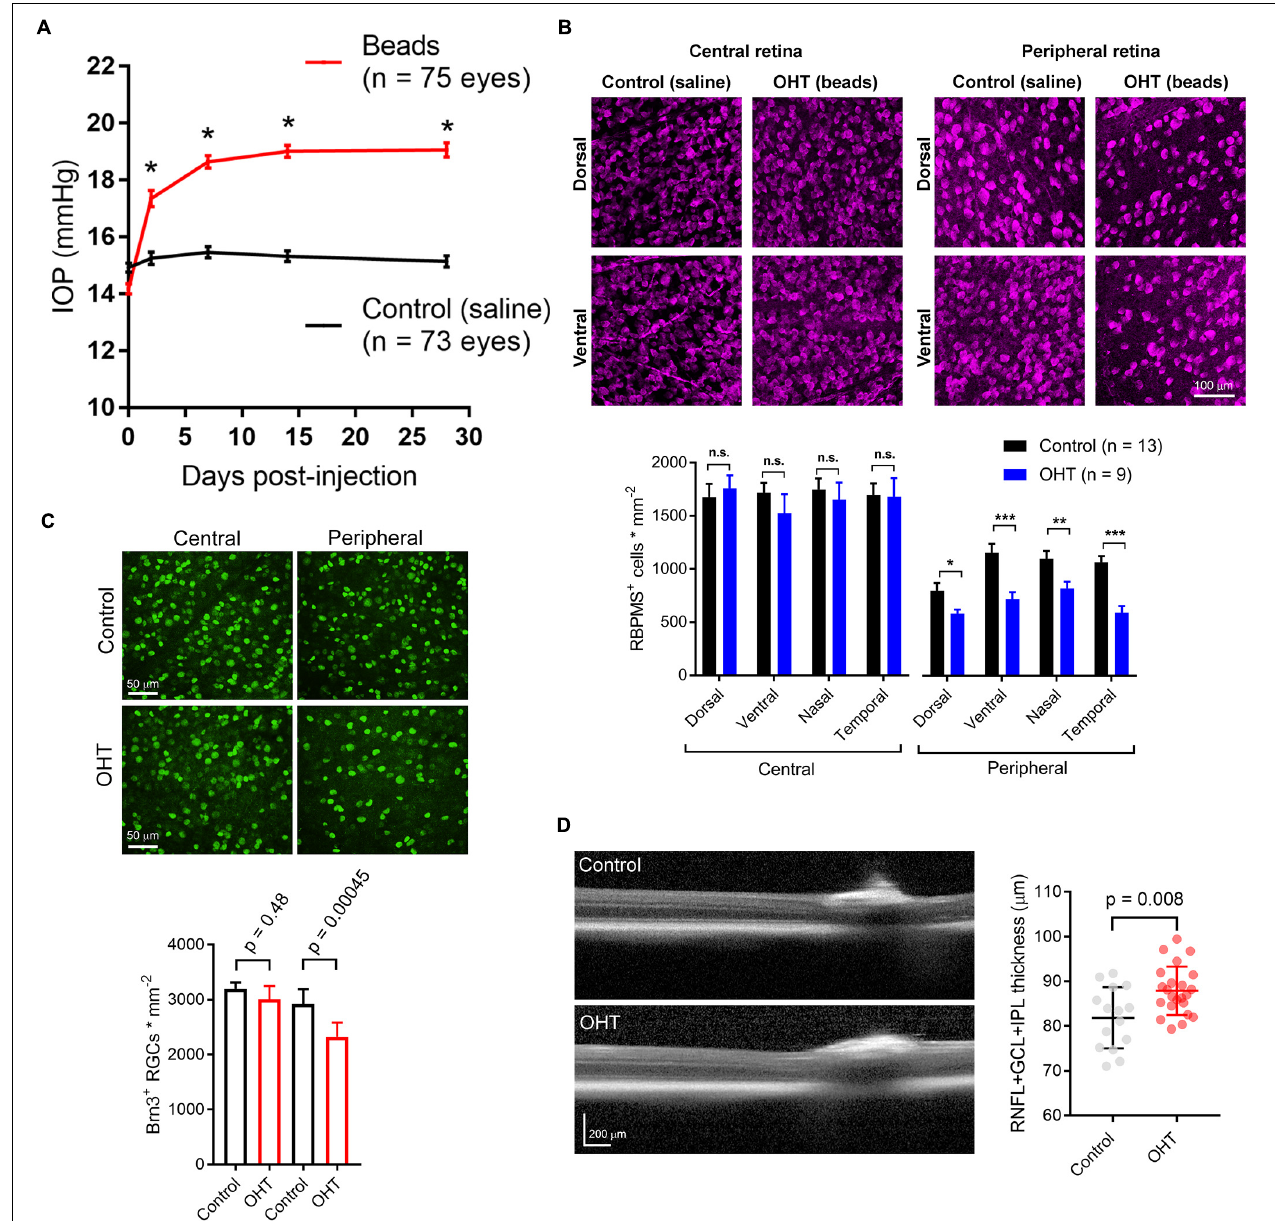
FIGURE 1 | Ocular hypertension leads to retinal ganglion cell loss and inner retinal pathology. (A) Anterior chamber injection of 10-micron microspheres led to an increase in intraocular pressure (IOP) while injection of saline did not. ∗ p < < 0.005. (B) 2-photon image of retinal ganglion cells labeled with an anti-RBPMS antibody. Images from ventral and dorsal quadrants are in central and peripheral retina ( ∼ 500 and ∼ 1700 µ m from optic nerve head) from saline- and bead-injected mice are shown. Lower panel shows quantification of RBPMS antibody-stained RGC density in central and peripheral retina showing lower RGC density in peripheral, but not central, retina in bead-injected mice. ∗ p < 0.05; ∗∗ p < 0.01; ∗∗∗ p < 0.001. (C) Images from central and peripheral retinas of RGCs labeled with and anti-Brn3 antibody. One eye received anterior chamber microbead injections while the contralateral eye received saline. Lower panel is quantification of Brn3 + RGC density showing a lower density in peripheral retina. Significance was assessed with a paired t -test ( n = 7 retinas from bead-injected and n = 7 retinas from contralateral saline-injected eyes). (D) Optical coherence tomography image showing identification of retinal layers. The RNFL + GCL + IPL thickness was measured. Right, quantification of OCT imaging (measured at 500 µ m from Bergmeister’s Papilla), shows a modest inner retinal thickening in ocular hypertensive mice. The RNFL + GCL + IPL thickness is plotted individually for each eye and the error bars are standard